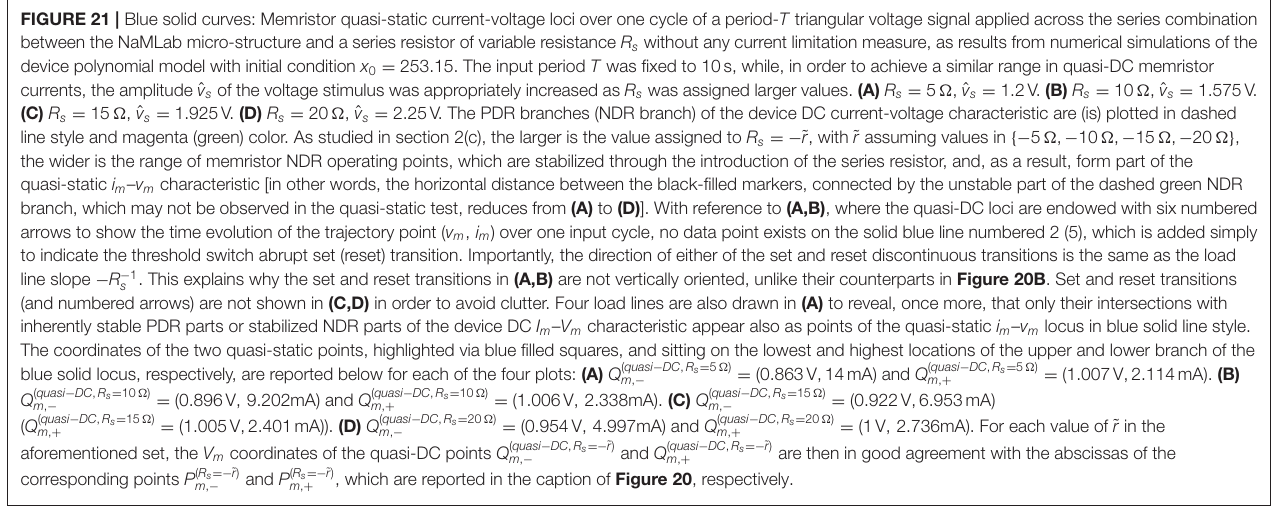
v s v s 5 (cid:127) , 1.2V. (B) R s 10 (cid:127) , 1.575V. ˆ ˆ = = = =